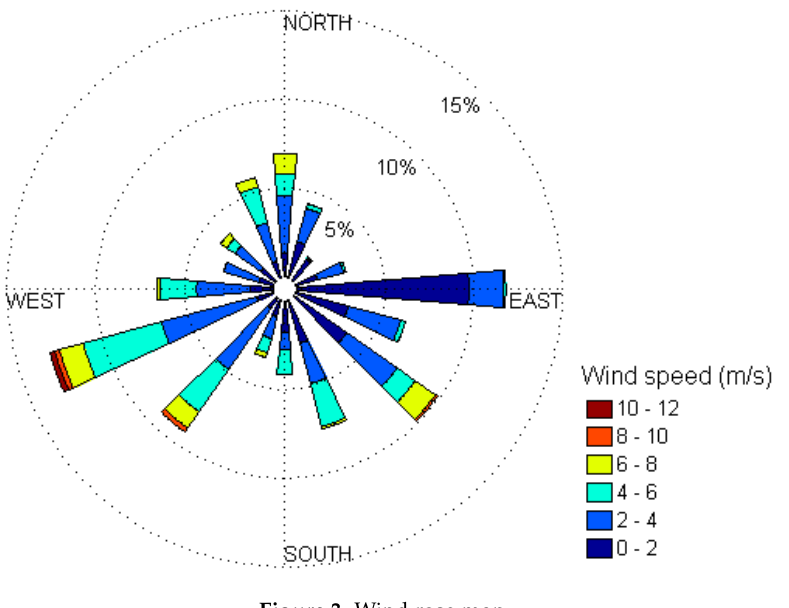
Figure 3. Wind rose map.